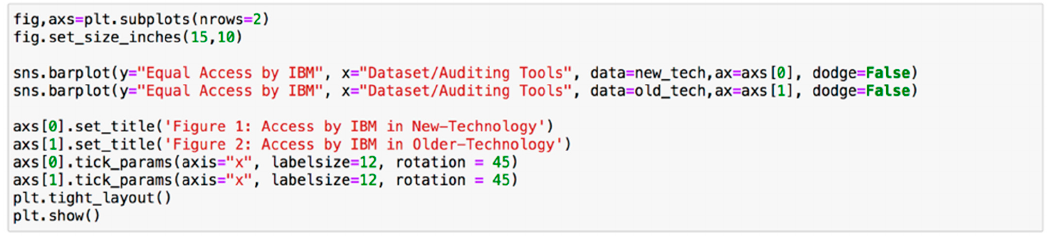
Figure 6. Presenting outcomes into plots — Equal Access by IBM (T9) .